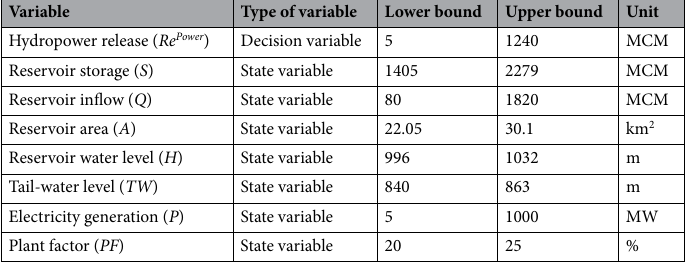
Table 2. Variables of the Karun-4 hydropower optimization